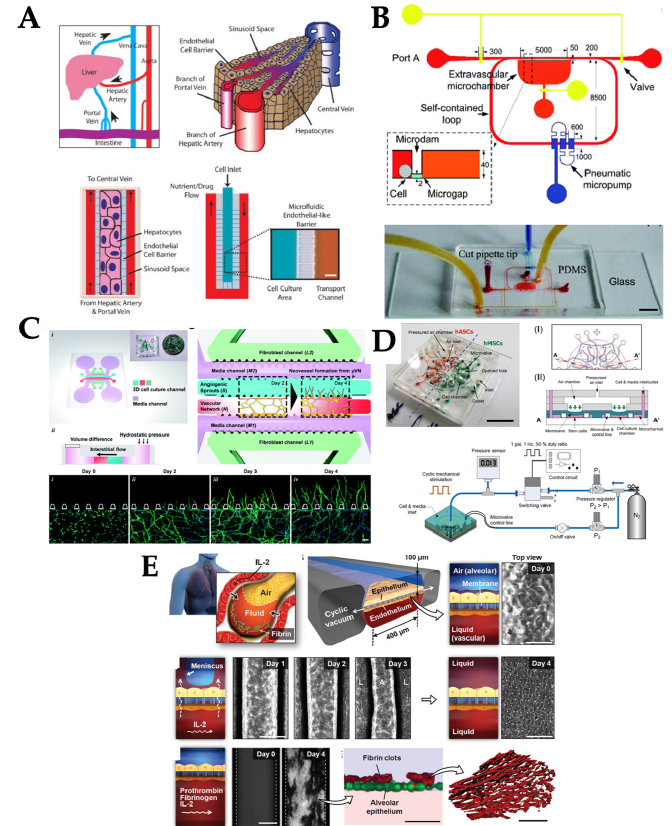
Figure 2. Different types of mechanical stimuli used in OOC systems. ( A ) Laminar flow presented in liver-on-chip, reproduced with permission from Reference [16]. ( B ) Pulsatile flow presented in vessel- on-chip, reproduced with permission from Reference [20]. ( C ) Interstitial flow presented in angiogenesis-on-chip, reproduced with permission from Reference [26]. ( D ) Compression stress